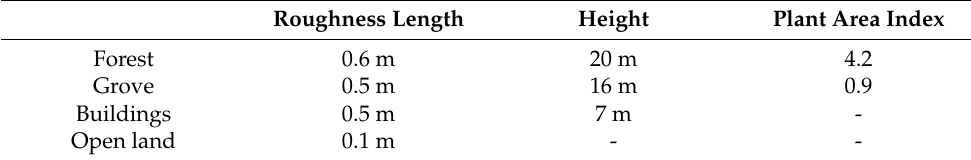
Figure 2. Planned wind turbines in the considered scenario and measurement setup, symbols as in Figure 1, with ( a ) terrain orography, and ( b ) land-use map. Table 1. Specifications of land-use types as used in the